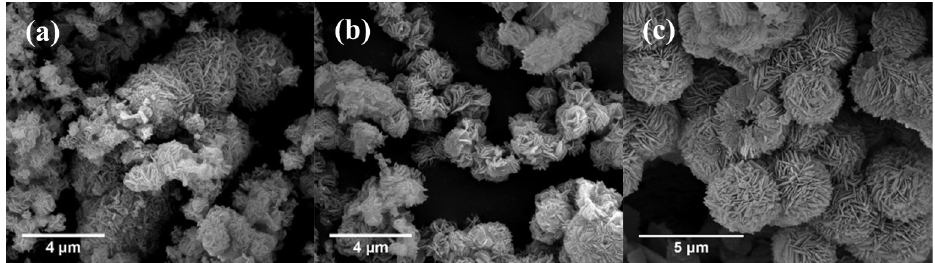
Figure 10. SEM images of ZnO@MOF-46(Zn) products after incubation at room temperature for 6 ( a ), 24 ( b ), and 48 h ( c ).